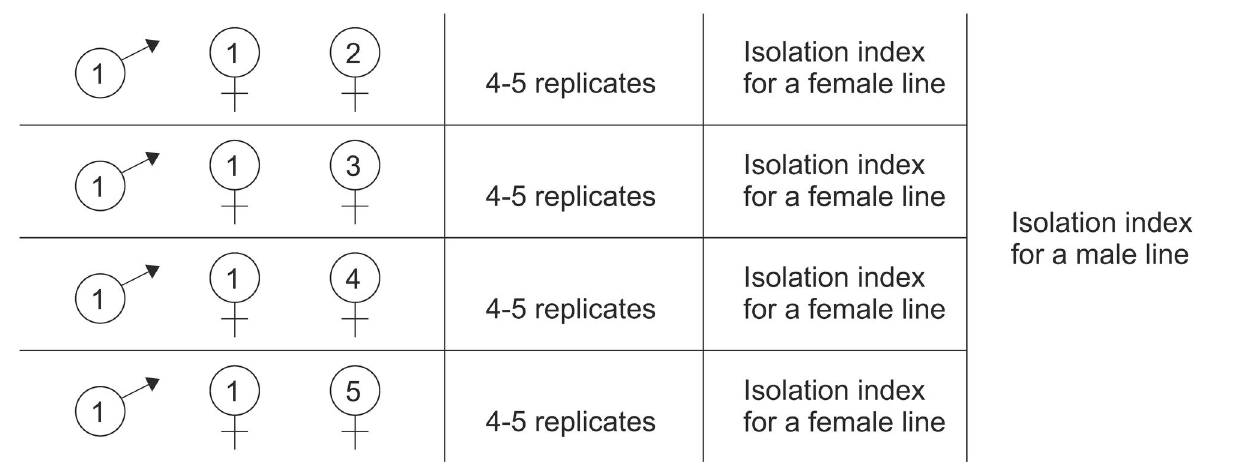
Figure 2. Schematic representation of the design of Assay II. Schematic representation of the design of Assay II and the way of calculating mate choice and post-zygotic reproductive isolation on the example of a male’s line 1. Procedures are described in the text. doi: